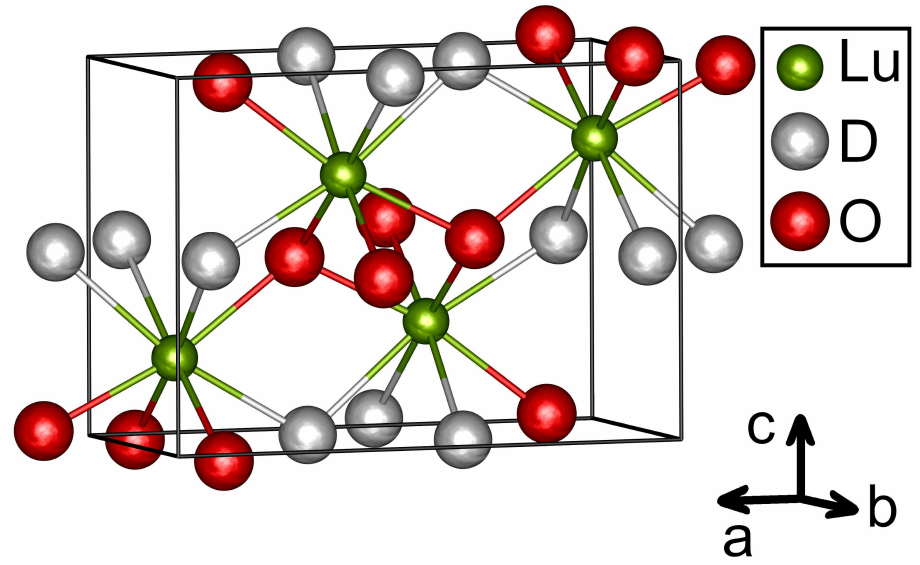
Figure 6. The crystal structure of orthorhombic